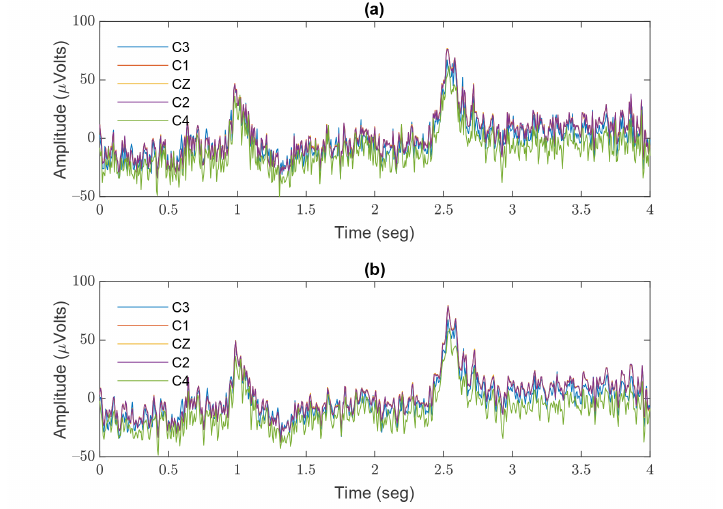
Figure 5. EEG signals acquired from electrodes C3, C1, CZ, C2, and C4. ( a ) Original EEG signal and ( b ) filtered EEG